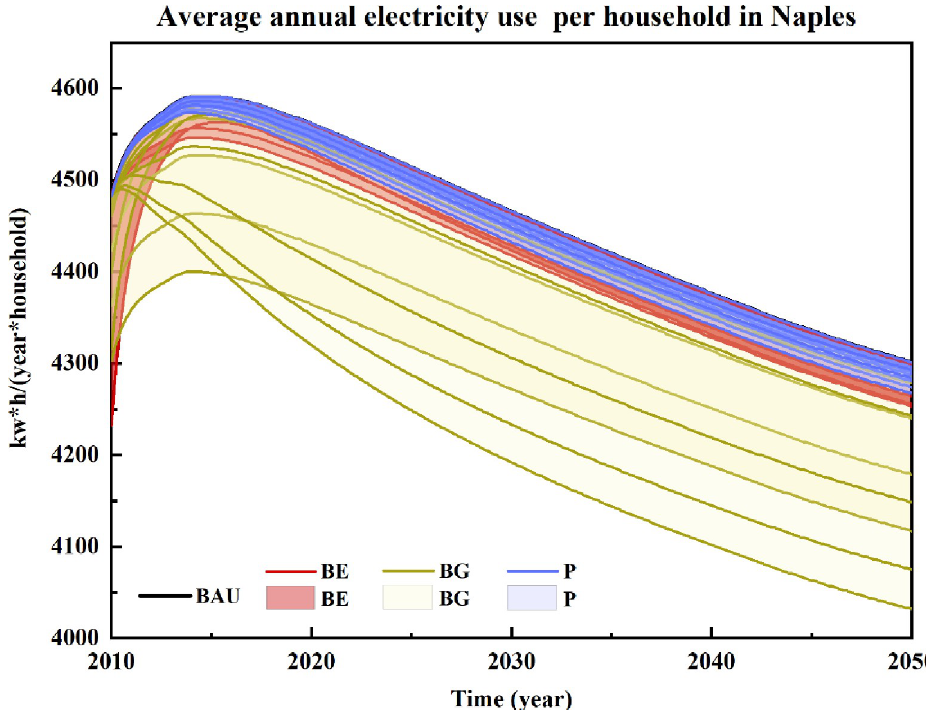
Fig 2. Scenarios of average annual household electricity use in the metropolitan city of Naples for the years 2010– 2050. Included scenarios: Business as usual (BAU), Price-based policies (P), Behavioural education actions (BE), and Behavioural guidance actions